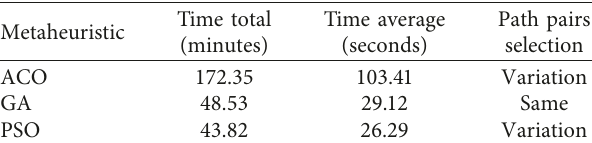
Table 2: Computation